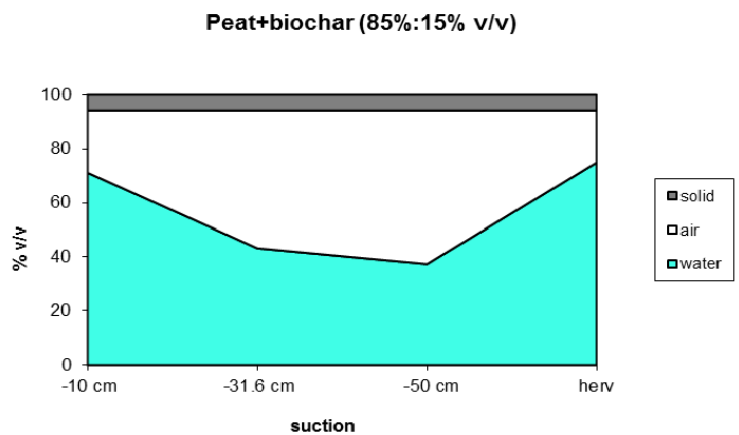
Figure 2. Water content in % v/v of a peat/biochar mixture (85%:15% v/v) as a function of suction strength in cm water column. The biochar particles are 3–4 mm and are produced from wood chips. The water holding capacity of the peat/biochar mixture is similar to the water holding capacity of peat because the large pores in between the biochar particles are now filled with peat. Based on the water holding capacity, the peat ‐ biochar mixture is suitable for application in horticulture.